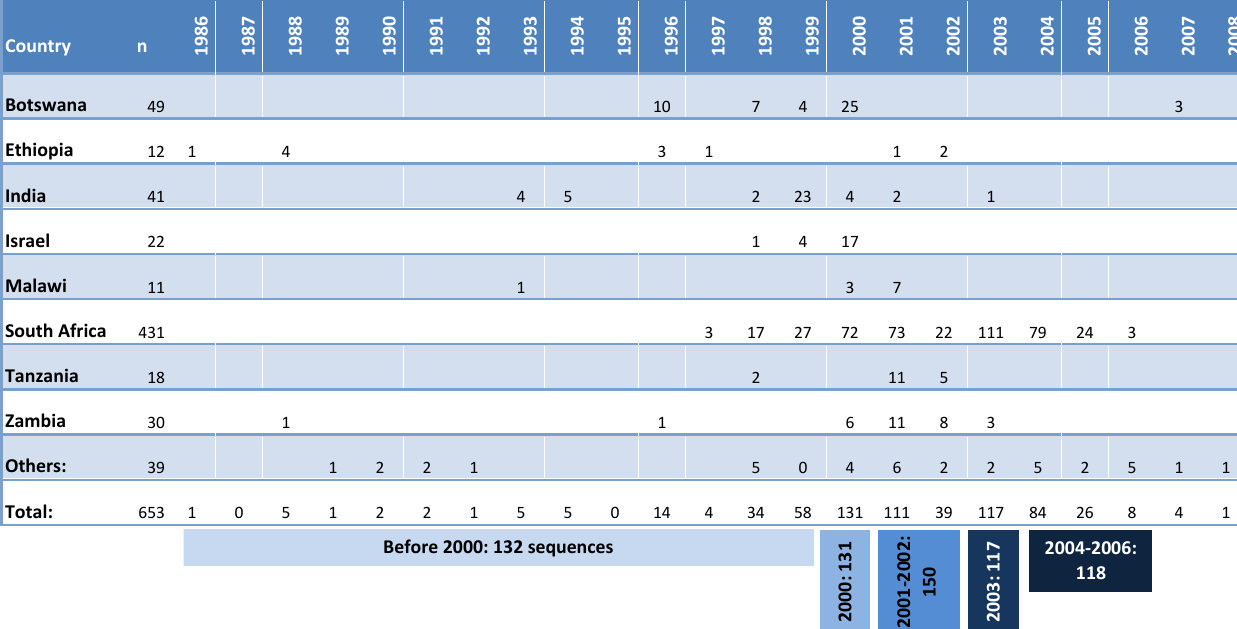
Table 3, and included 431 sequences from South Africa, 49 sequences from Botswana, 41 sequences from India, 30 sequences from Zambia, 22 sequences from Israel, 18 sequences from Tanzania, 12 sequences from Ethiopia, 11 sequences from Malawi, and small numbers of sequences from Argentina (2), Brazil (6), China (2), Cyprus (5), Djibouti (1), Denmark (2), Spain (3), Georgia (1), Kenya (3), Senegal (1), Somalia (1), Uganda (2), USA (2), Uruguay (1), Yemen (1), and Zimbabwe (6). Sampling time of the retrieved sequences is also presented in Table 3. Most of the retrieved samples were sampled between 1998 and 2005. For analysis of viral dynamics the retrieved sequences were grouped by their sampling time. The 2007–2008 group included only five sequences, and was not used in the analysis of amino acid frequencies. The extended consensus sequence was built for each group. Frequencies of amino acid at each residue position were expressed as a fraction of 1. The low threshold of detection was 0.005. Table 3. HIV-1 subtype C gag sequences (>1,000 bp) included in the analyses by country of origin and by year of sampling. Countries with fewer than 10 sequences are presented as ‘Others’, and include Argentina (2), Brazil (6), China (2), Cyprus (5), Denmark (2), (2), Uruguay (1), Yemen (1), and Zimbabwe (6). Groups of analyzed gag sequences by sampling year are outlined at the